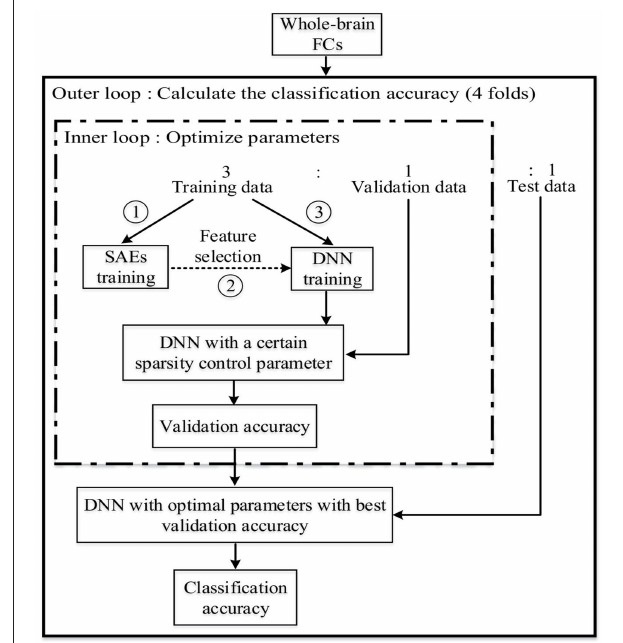
FIGURE 2 | The nested CV framework for the DNN training, testing, and parameters